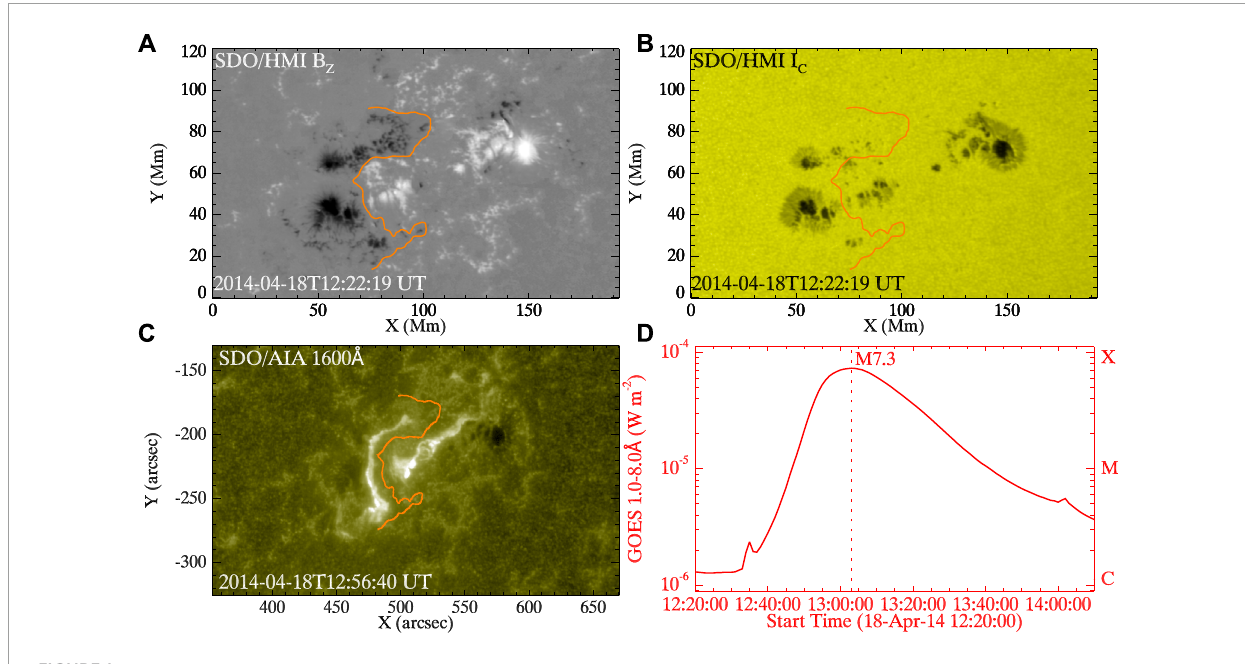
FIGURE 1 Overview of NOAA AR 12036 and its first major eruption, an M7.3-class flare (SOL 2014-04-18T12:31). (A) Photospheric B z map prior to the flare, in which B z saturates at ± 2000 G. (B) Photospheric continuum intensity at the same time as panel (A) . (C) SDO/AIA 1600-Å images taken during the flare. The orange curves in the three panels are the PILs where the eruption occurs. (D) Light curve of the GOES 1-8 Å flux during the M7.3-class flare. The vertical line indicates the peak time of the flare.